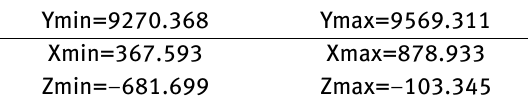
Table 1: Ranges of the sulfur ore entity model